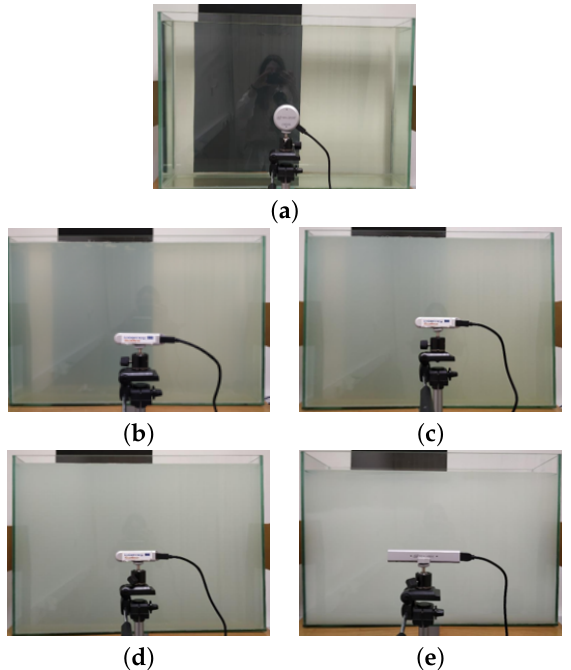
Figure 11. Pictures showing the aquarium at different stages of the experiment. ( a ) water full